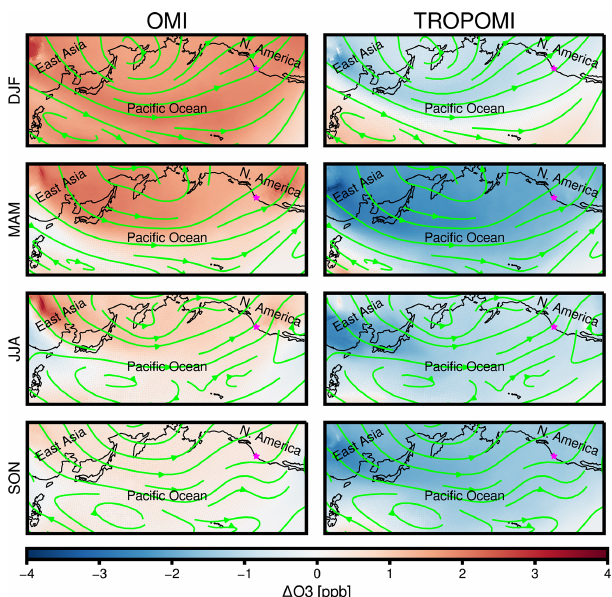
Figure 11. Changes in 2019 season-average free-tropospheric O 3 concentrations (averaged between 750 and 250hPa) simulated over the North Pacific Ocean using lightning and anthropogenic NO x emissions inferred with OMI or TROPOMI observations, relative to simulations using prior ANO x emissions and updated LNO x emissions. Differences are shown for winter (DJF), spring (MAM), summer (JJA), and fall (SON). Arrows depict season-average free- tropospheric winds (750–250hPa). Star marker indicates location of Trinidad Head,